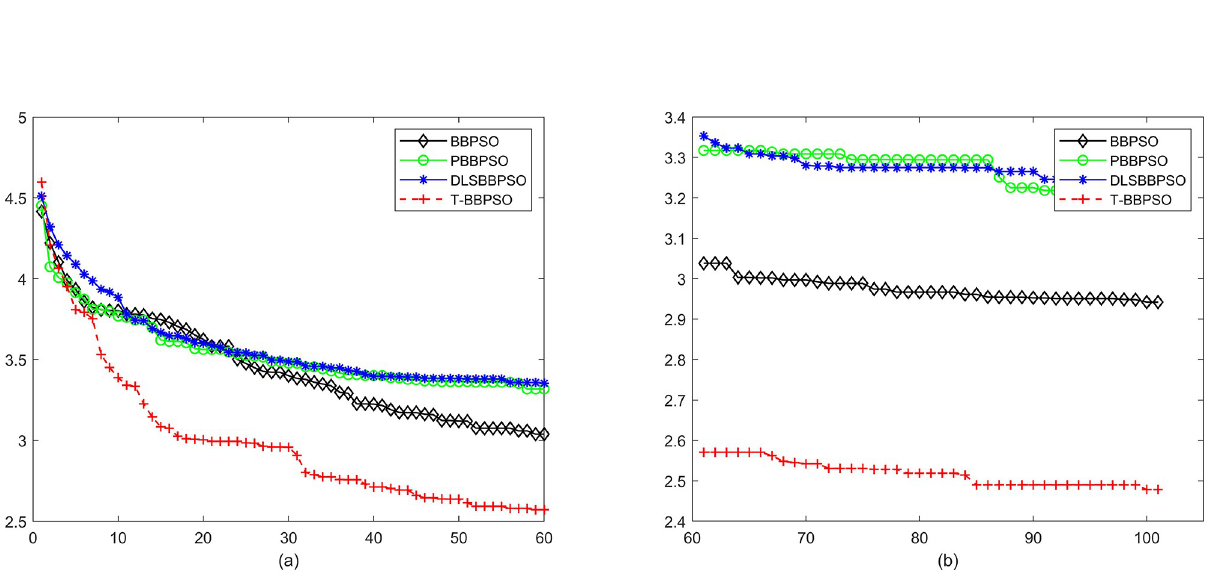
Fig 14. Comparison of convergence speed between BBPSO, PBBPSO, DLS-BBPSO and TBBPSO, f 12 , (a) iteration 0–6000, (b) iteration 6000–10000 the unit is 100 iteration.